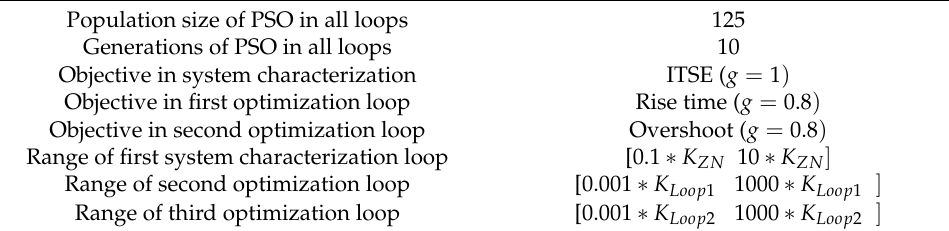
Table 2. Selected parameters for the application of the method for multi-objective optimization of PID control in this